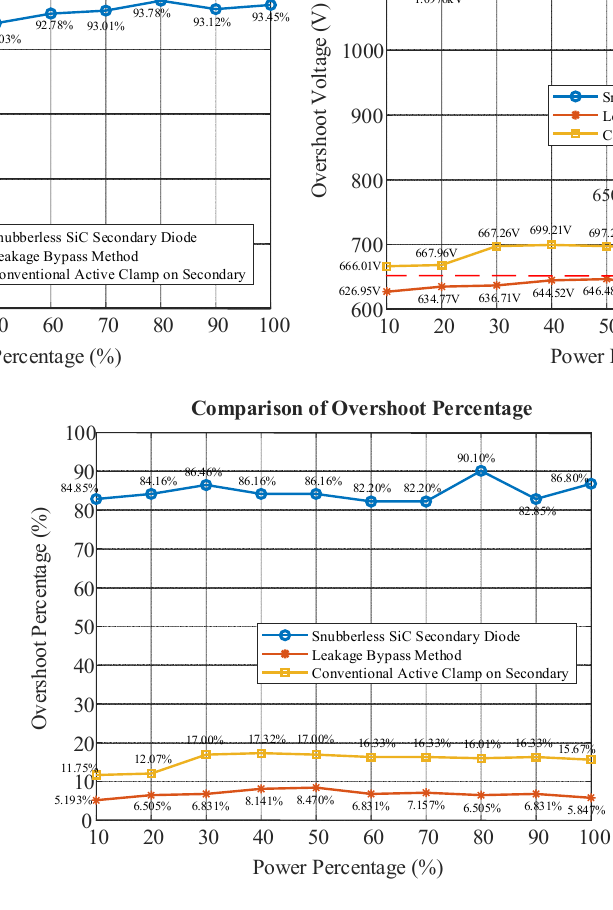
Figure 20. Experimental performance comparison with different techniques.